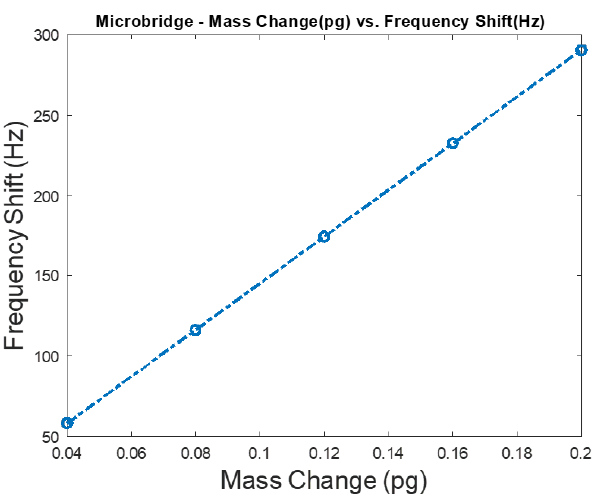
Figure 12. Sensitivity analysis for a silicon bridge mass sensor when the target adsorbed mass is increased from 0.16 to 0.4 pg. The investigated sensor has 40 μm length and 20 μm width when the thickness and cavity are 0.5 μm. A bias of 20 V DC, which is chosen close to the device’s pull-in voltage, is applied to the microbridge mass sensor.